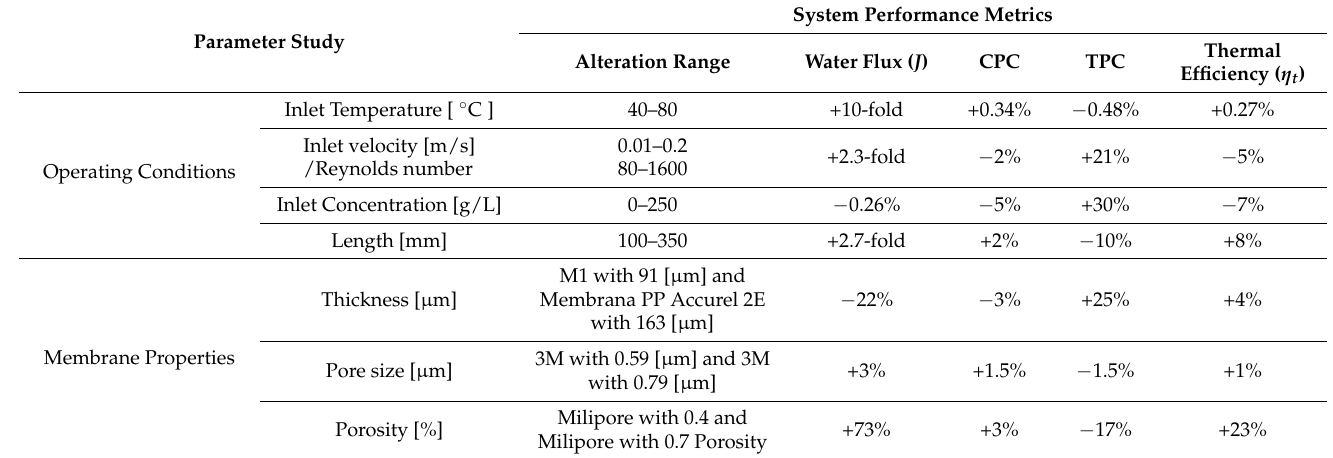
Table 3. Parametric study of DCMD